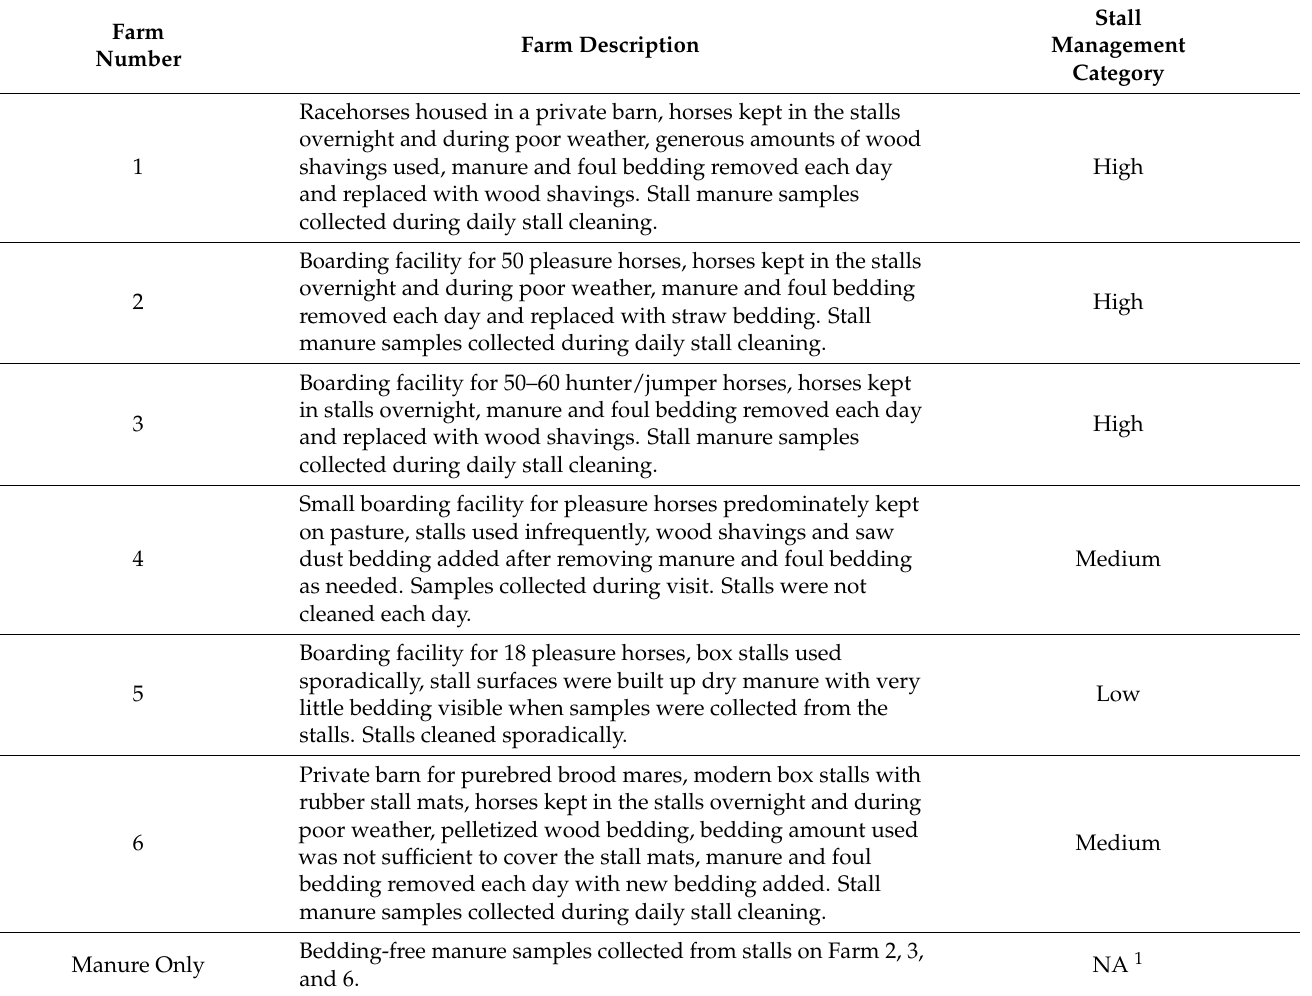
Table 1. Description of the six horse farms and manure samples collected, and classification based on stall